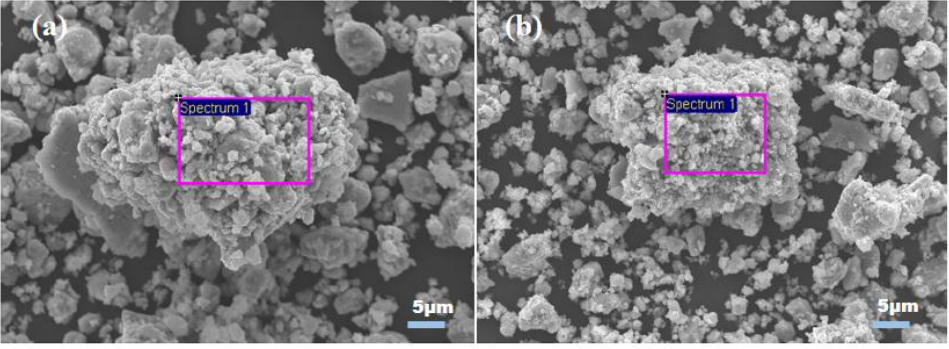
Figure 2. Morphology of the milled powders ( a ) 30 vol % TiC, nanocomposite A; and ( b ) 30 vol % TiC, nanocomposite B (higher-magnification SEM images; the rectangles mark areas from which energy-dispersive spectroscopy (EDS) spectra were taken).